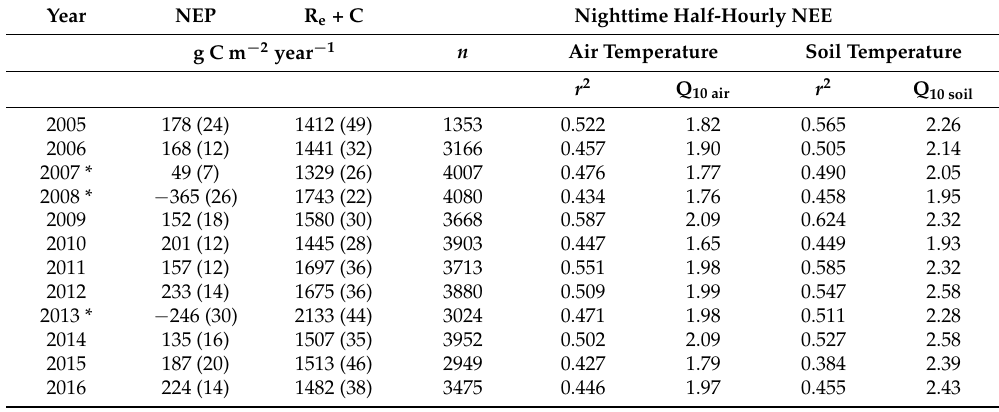
Table A2. Annual net ecosystem production (NEP), the sum of ecosystem respiration and combustion loss during prescribed fires (R e + C), and information for half-hourly nighttime net ecosystem exchange of CO 2 (NEE) derived from eddy covariance and biometric measurements at the pine stand. Values in parentheses for NEP are the maximum deviations from annual values as a result of gap filling using ± 1 SE of parameter values derived from daytime data during the summer (1 June to 31 August) or all nighttime data, and values in parentheses for R e + C are the maximum deviation from annual values as a result of gap filling using ± 1 SE of parameter values derived from all nighttime data. The number of half-hourly values when u* ≥ 0.2 m s − 1 , Pearson’s product moment correlation coefficients for the modeled relationship between air or soil temperature, and temperature coefficients for air (Q 10 air ) and soil (Q 10 soil ) temperature for 10 to 20 ◦ C are shown. * indicates years when disturbance